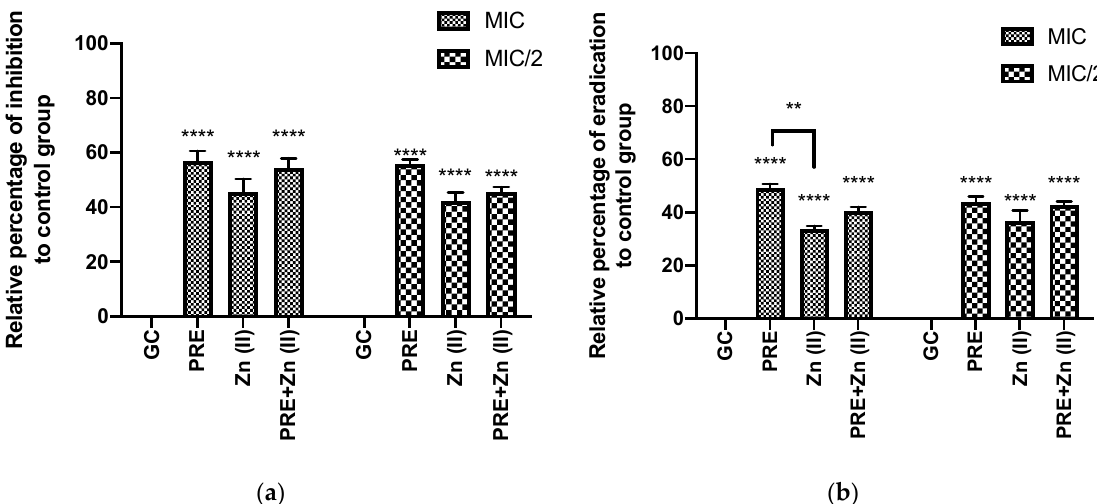
Figure 3. ( a ) Percentage biofilm inhibition and ( b ) biofilm eradication by PRE, Zn (II) and PRE/Zn (II) in combination at MIC and half of MIC values (MIC/2) against M. luteus , using the in vitro crystal violet assay. All data are represented as mean ± SEM, n = 3. Statistical significance indicated at ** p < 0.01, and **** p < 0.0001, compared to untreated growth controls and compared between treatment groups. Note: a significant effect of PRE, Zn (II), and the PRE/Zn (II) combination in reducing biomass compared to untreated growth control group in biofilm inhibition and biofilm eradication